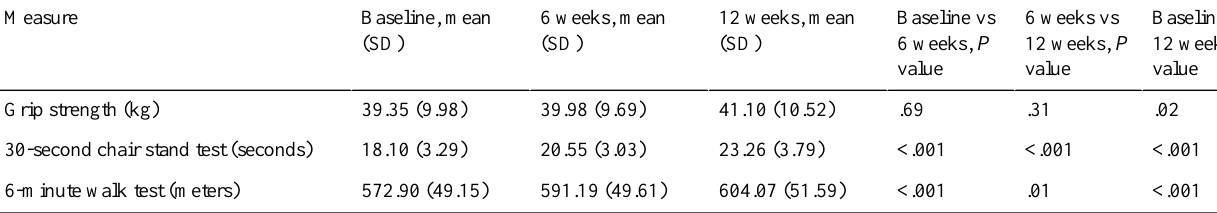
Table 2. Changes in physical fitness measures.